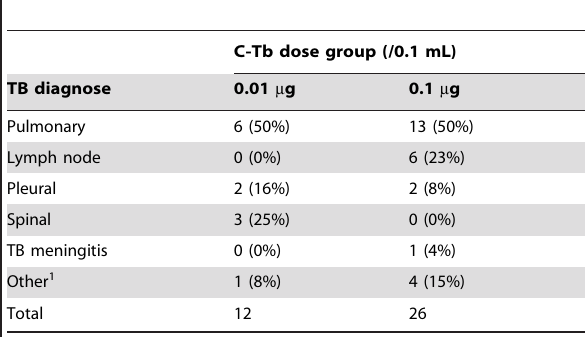
Table 1. Distribution of primary site of tuberculosis infection and number of patients in dose-finding